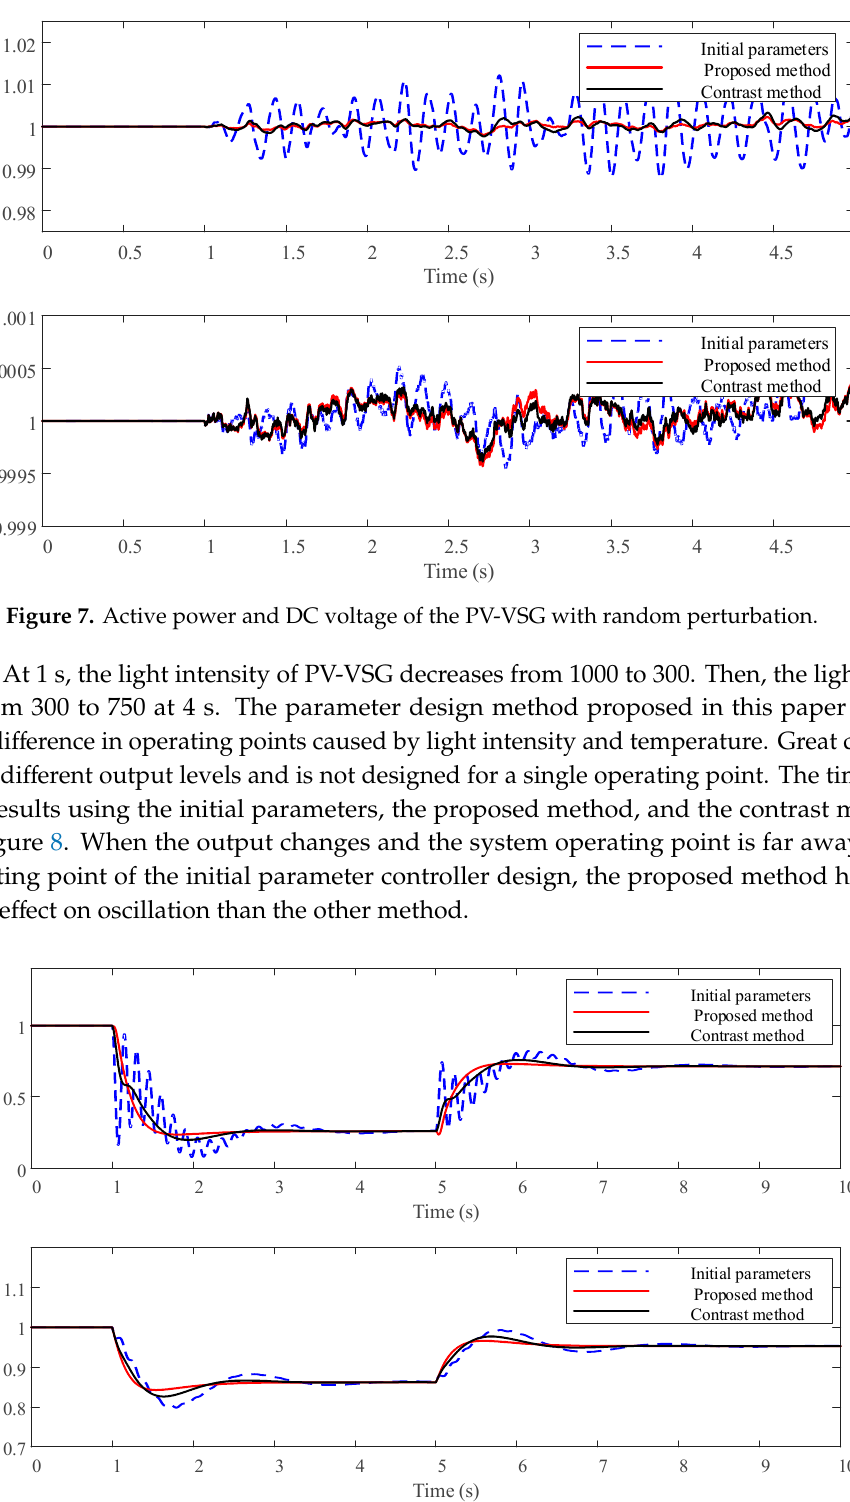
Figure 8. Active power and DC voltage of the PV-VSG with big drift at the operating point. Case E: A three-phase temporary fault is applied at the bus of PV-VSG at t = 1 s and is cleared 20 ms later. The dynamic responses of the PV-VSG are shown in Figure 9. The four blue, red, and black curves represent the dynamic active powers and DC voltage of the PV-VSG with the initial parameters, with the proposed method, and with the contrast method, respectively. It can be seen from the figure that the proposed method gives a better damping performance under fault conditions.